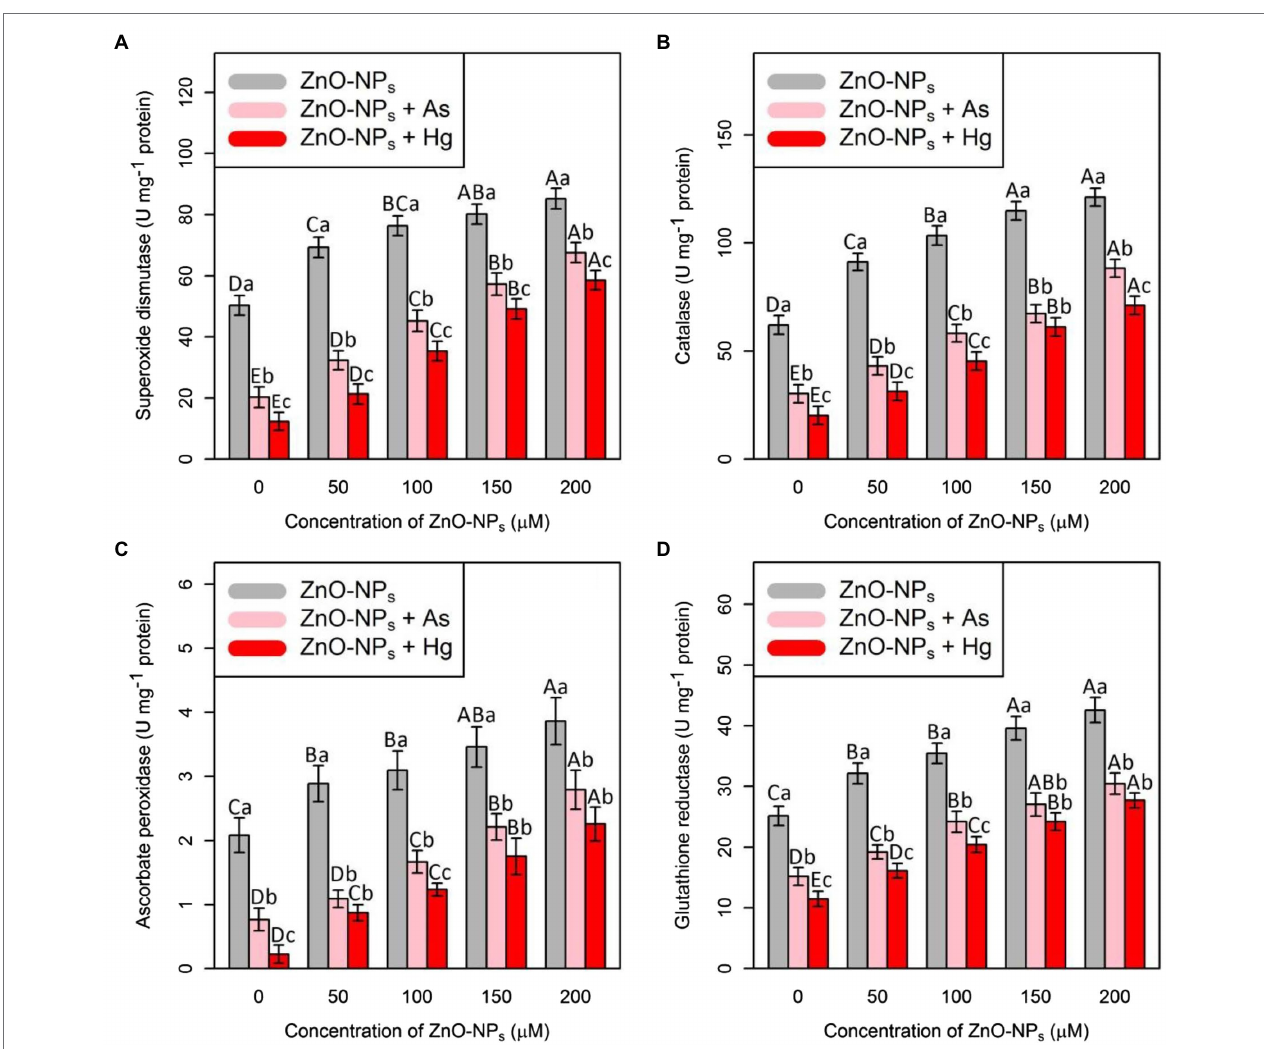
FIGURE 1 | The impact of zinc oxide nanoparticles (ZnO-NPs) concentrations on the antioxidant enzyme activities (A) superoxide dismutase (SOD), (B) catalase (CAT), (C) ascorbate peroxidase (APX), and (D) glutathione reductase (GR) in bamboo species ( Pleioblastus pygmaeus ) with 150 μ M As and 150 μ M Hg. The capital letters indicated statistically significant differences across various concentration of ZnO-NPs alone or in combination with 150 μ M As and 150 μ M Hg (the bars with the same colors), while the lowercase letters indicated statistically significant differences within each level of ZnO-NPs alone or in combination with 150 μ M As and 150 μ M Hg (the bars with different colors) according to Tukey ′ s test ( p <